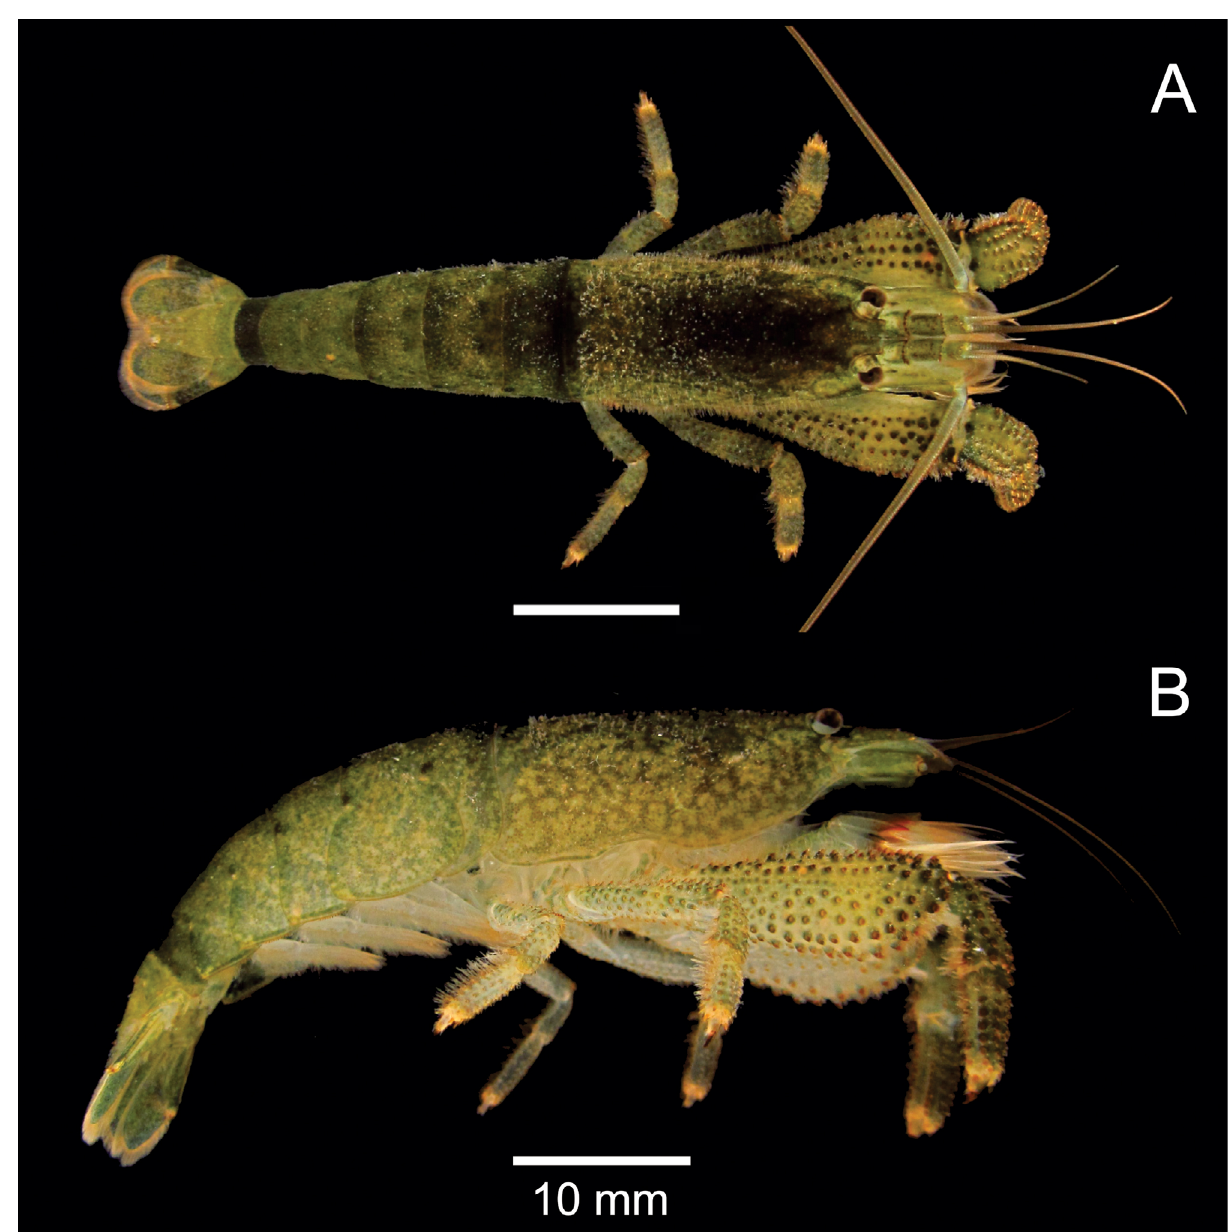
Figure 1. ( A ) Dorsal and ( B ) lateral view of Atya scabra (Leach, 1816) captured on the São Francisco River, Sergipe, Brazil (Photo: Alves,